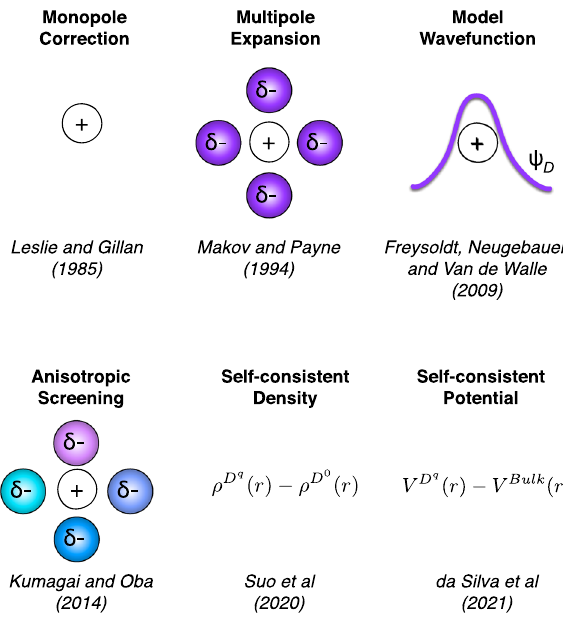
Fig. 2 Defect correction schemes. Illustration of the variety of correction procedures for the calculation of charged defects under periodic boundary